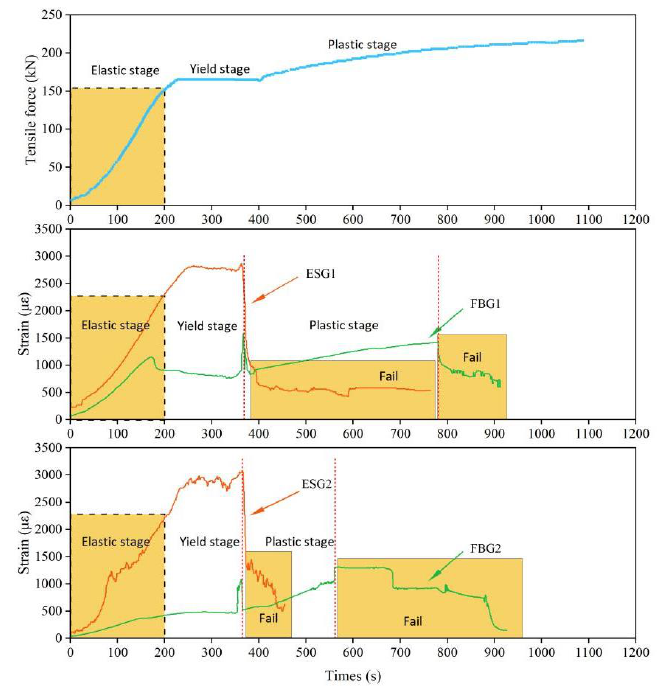
Figure 10. Measurement results of each test instrument.